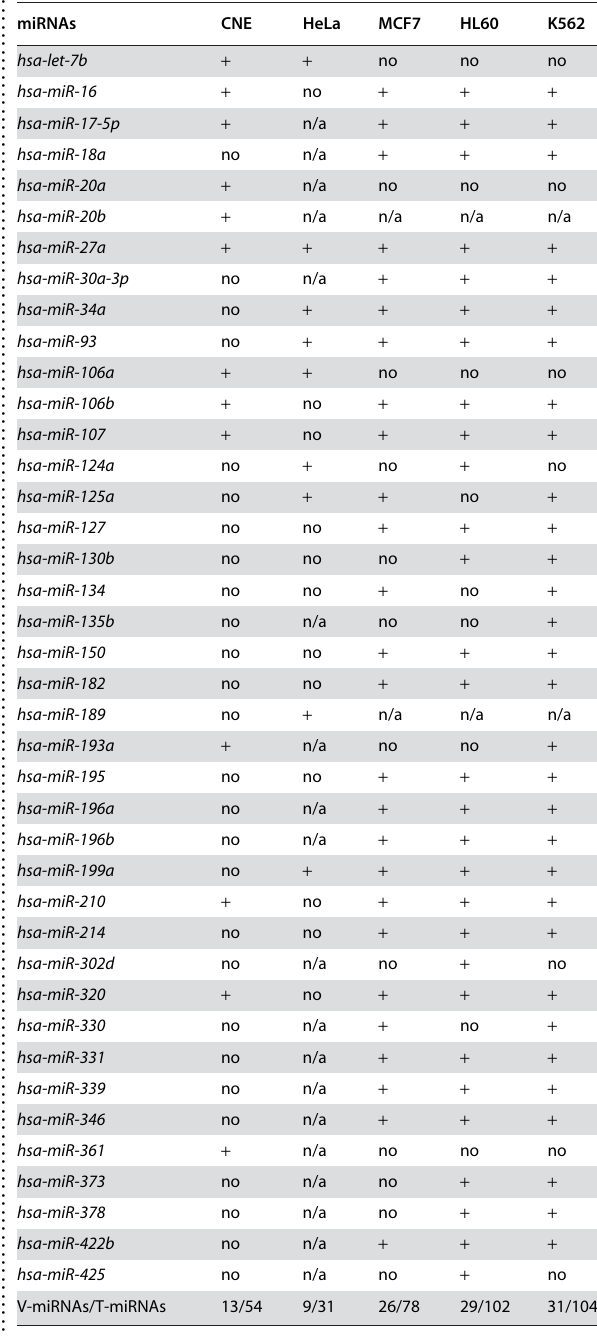
‘‘ + ’’ indicates those miRNAs which are expressed in a specific cell line and have predictive targets in the 3 9 untranslated region of VEGF; ‘‘ 2 ’’ indicates those miRNAs which are not expressed in a specific cell line; ‘‘n/a’’ indicates that the miRNA is not within the detection range in certain experimental approaches; ‘‘V-miRNAs’’ means miRNAs targeting VEGF; T-miRNAs means total miRNAs which are expressed in the cell